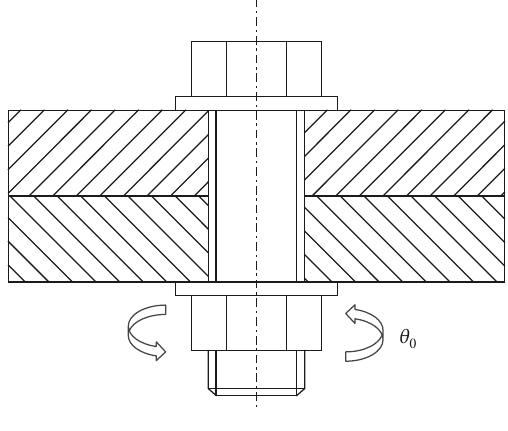
Figure 8: The loading diagram.